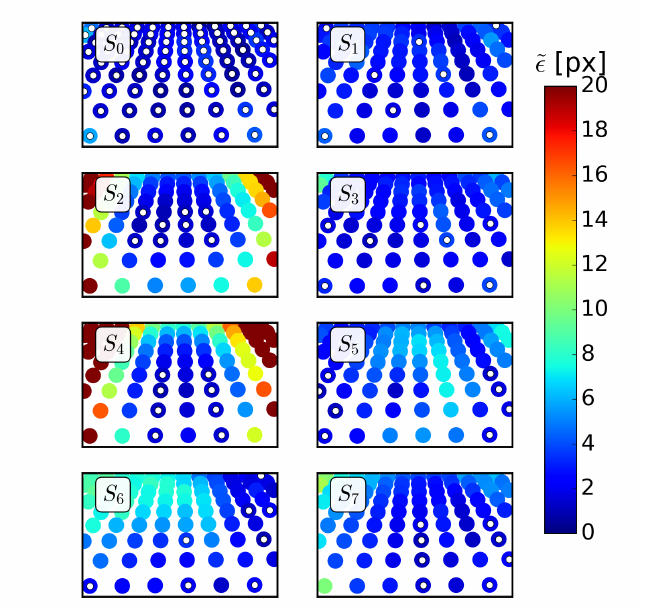
Figure 7. Errors ˜ (cid:101) for M 2 and angle A 1 at all the available points for the different sets S k . The GCPs for each set are here highlighted with white circles in the center and correspond to the points in Figure